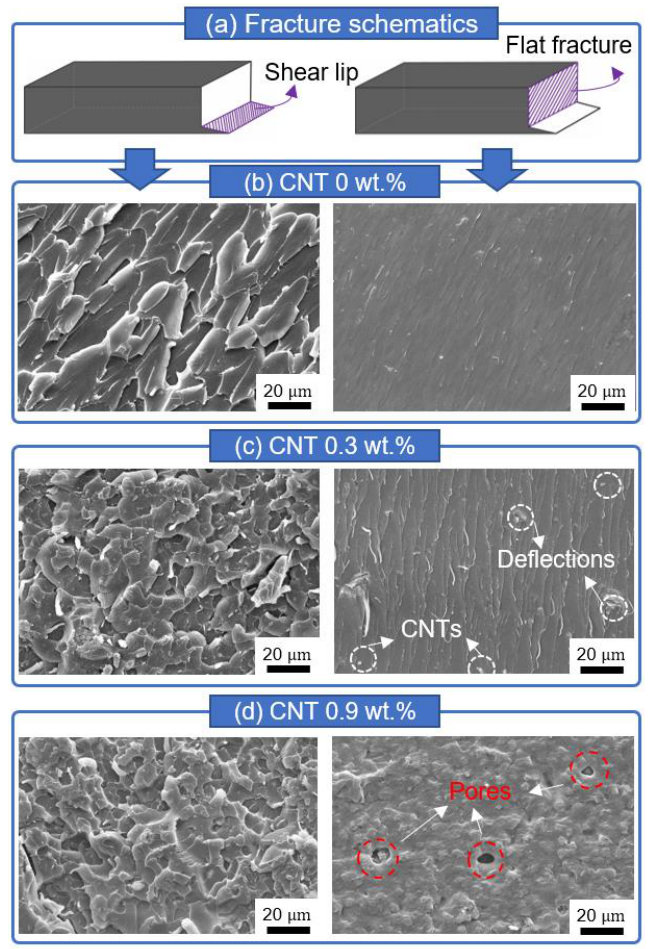
Figure 7. Typical SEM images of CNT-added specimens after the three-point bending test: ( a ) Schematic description shows typical fracture surfaces of combined shear lip and flat fracture. ( b ) SEM images of pure resin show coarse dimples with torn-off traces on the shear lip region, whereas it exhibits a smooth and even surface on the flat fracture region. ( c ) Fracture surface of the 0.3 wt.% CNT-added specimen contains smaller dimples decorated with CNT particles, deflecting crack propagation. ( d ) Fracture surface of the 0.9 wt.% CNT-added specimen exhibits a large number of pores detrimental to mechanical strength.